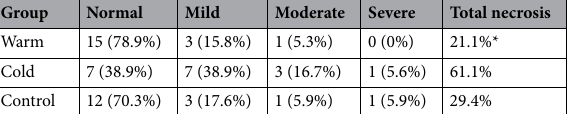
Table 1. Tissue necrosis 1 day after intravascular injection. *P < 0.05 (warm group vs. cold